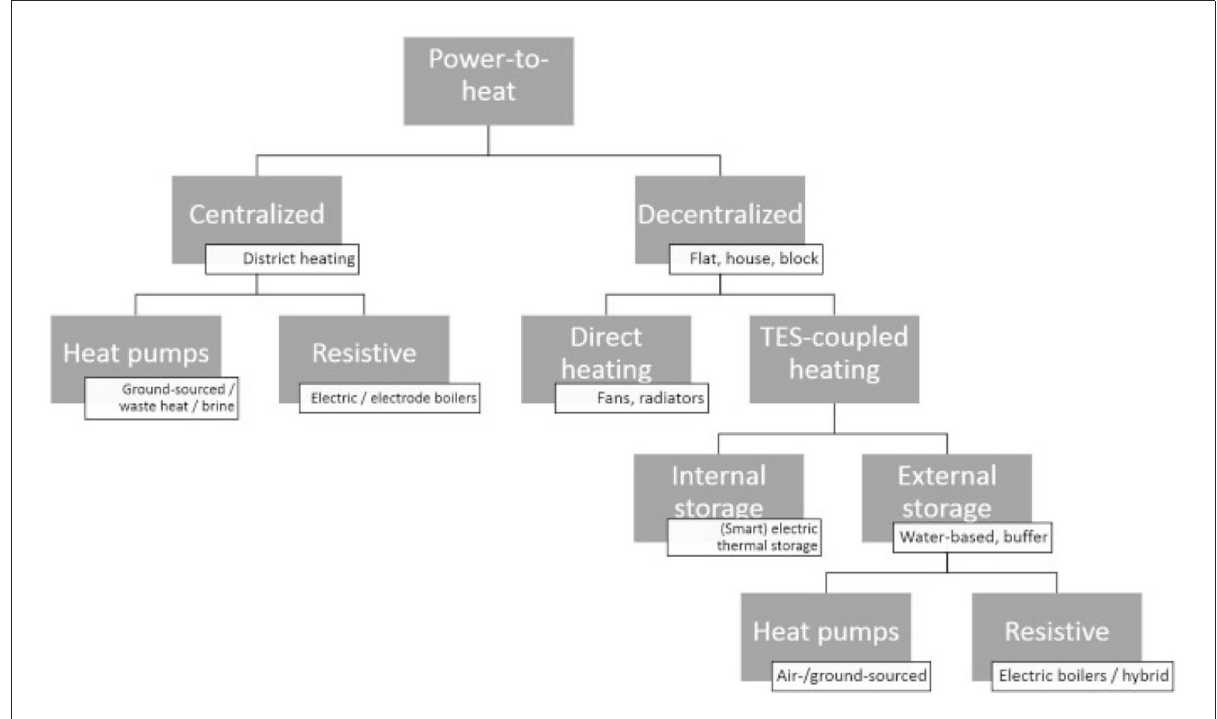
FIGURE3 Residential power-to-heat options (Energiewende, 2014).